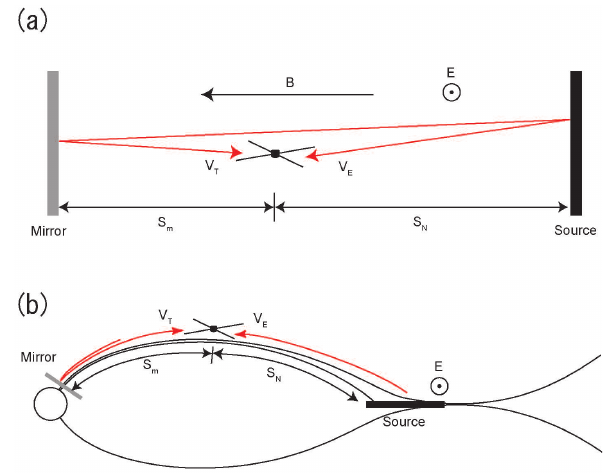
Fig. 5. Schematic pictures of the Onsager model: (a) an original configuration, (b) a more realistic